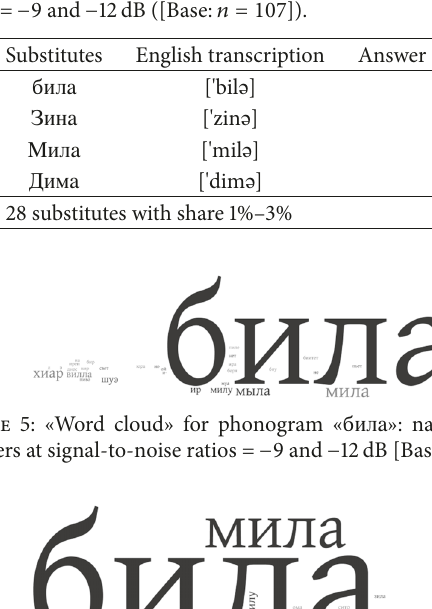
Figure 8: Utterance miss (false negative error) for utterances in Russian against white noise: comparison of male and female